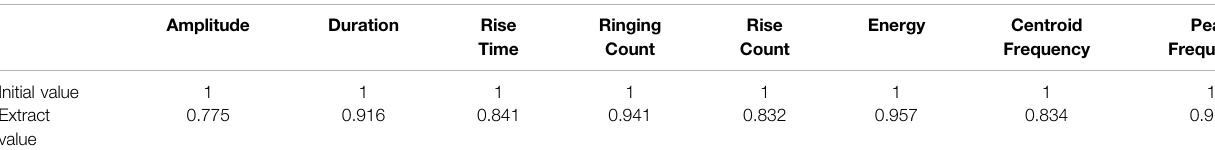
TABLE 3 | Common factor variance of characteristic parameter (sample 1).